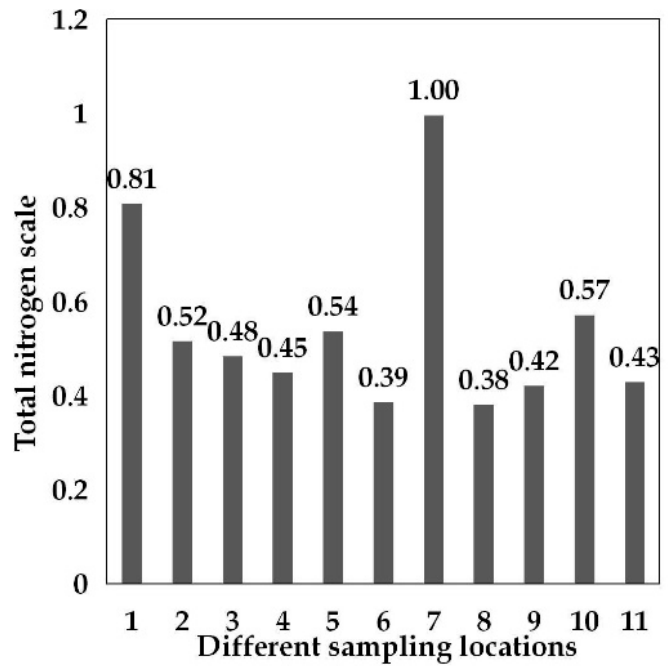
Figure 9. Fixed scale of pollutant nitrogen rate at different sampling points.